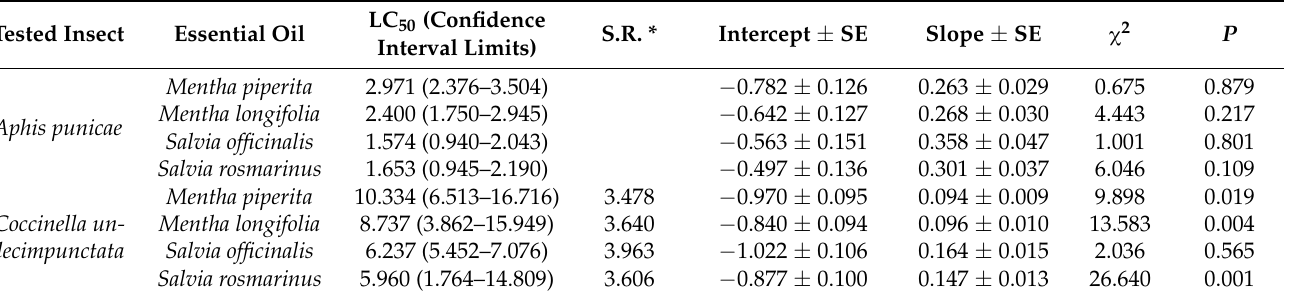
Table 2. LC 50 values ( µ g/mL) for the tested four plant essential oils against imago of Aphis punicae and 3rd instar of Coccinella undecimpunctata larvae.